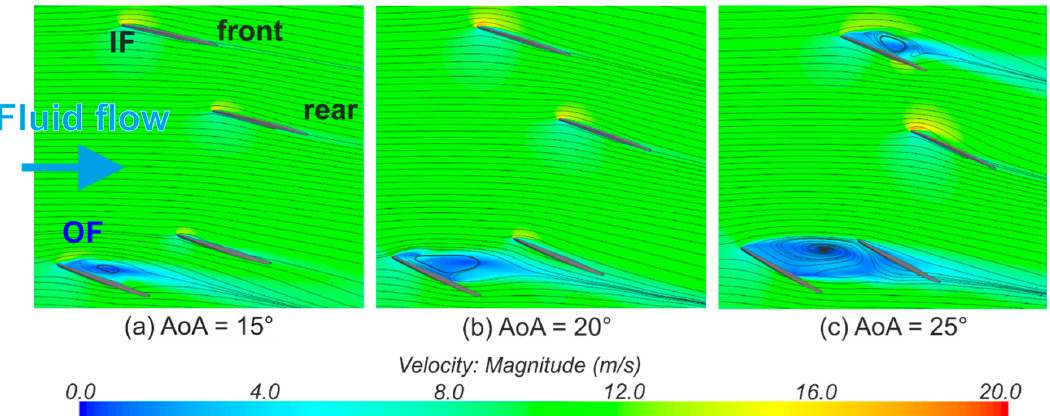
Figure 11. Governing velocity field and streamlines around the fins for ( a ) AoA = 15°, ( b ) AoA = 20°, and ( c ) AoA =